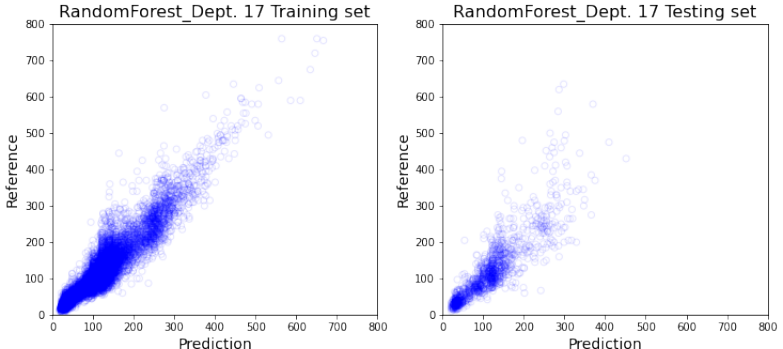
Figure A4. Model Performance of RandomForest on Dept.17. The visualization of training and testing data for department specific model on department 17 with Random Forest.